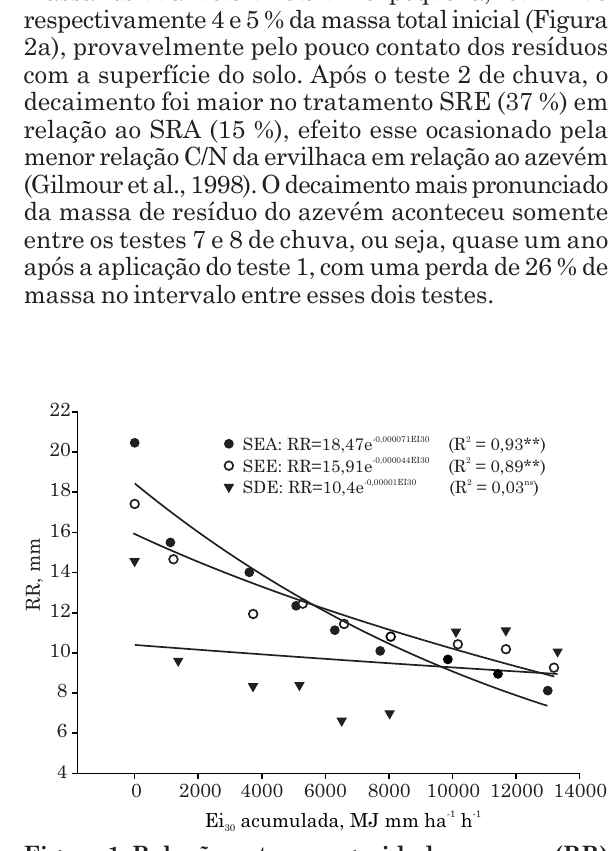
Figura 1. Relação entre a rugosidade ao acaso (RR) da superfície de um Cambissolo Húmico alumínico léptico e o índice de erosividade das chuvas, EI 30 , após a realização de uma escarificação em diferentes manejos do solo. SEA: solo escarificado com raiz de azevém; SEE: solo escarificado com raiz de ervilhaca; e SDE: solo descoberto escarificado.